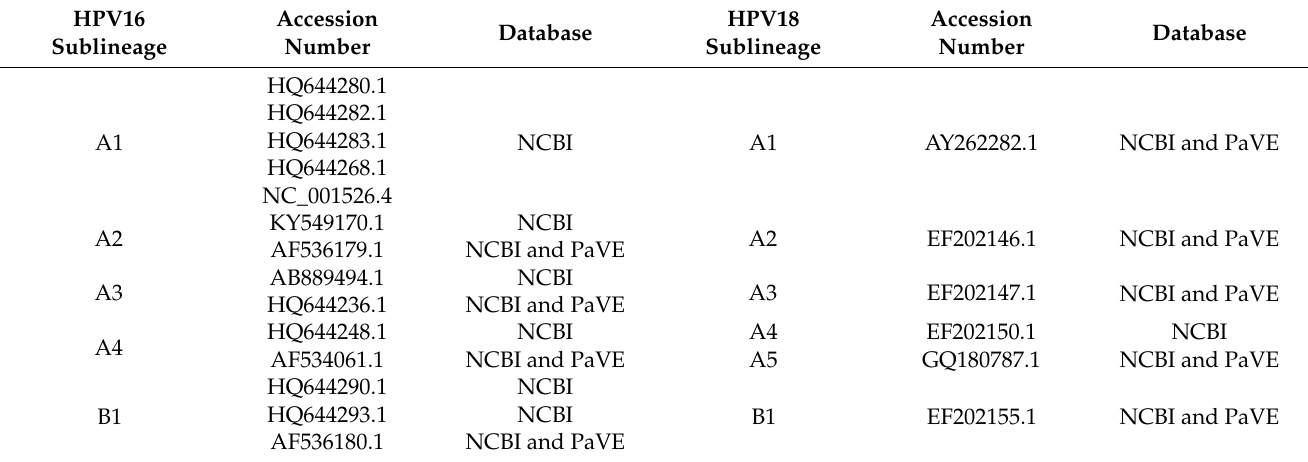
Table 5. HPV16 and HPV18 sublineage references for phylogenetic tree